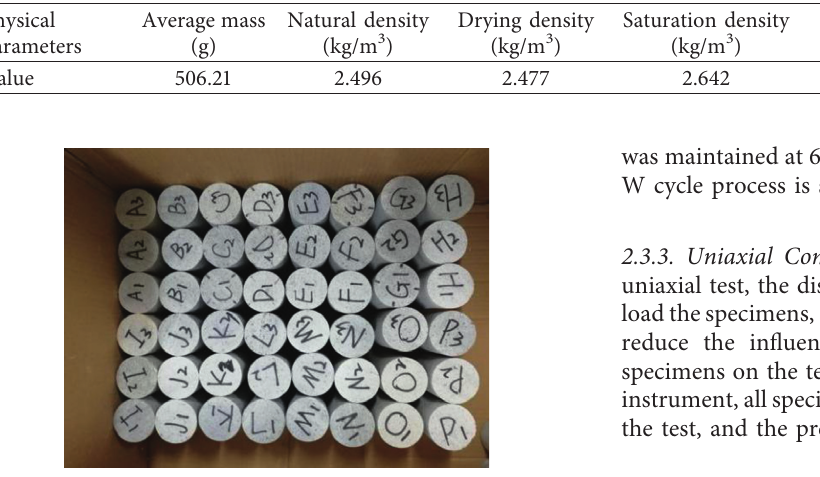
Figure 4: Test results of thin sections of rock specimens (a) rock specimens and (b) Identification results of thin sections. Table 2: Average of basic physical parameters of sandstone specimens.